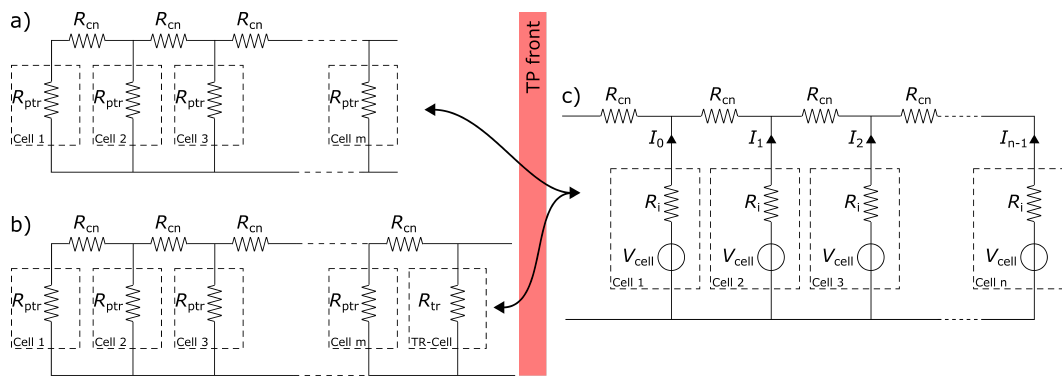
Figure 8. Equivalent circuit model of a cell stack in thermal propagation (TP) without measurement equipment. ( a ) ECM of the burned part while there is currently no cell in TR; ( b ) ECM of the burned part while a cell is in TR; ( c ) ECM of the healthy part with intact